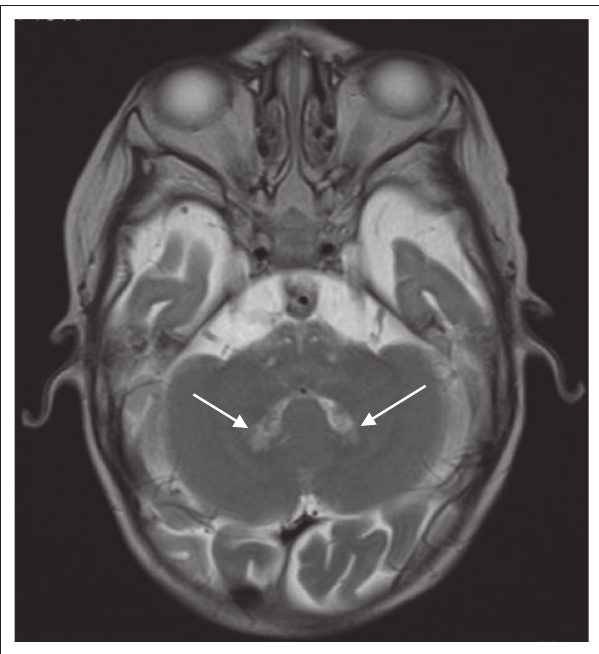
FIGURE 5: T2 axial image of patient 2. Increased signal intensities in the cerebellar dentate nuclei bilaterally (arrows).